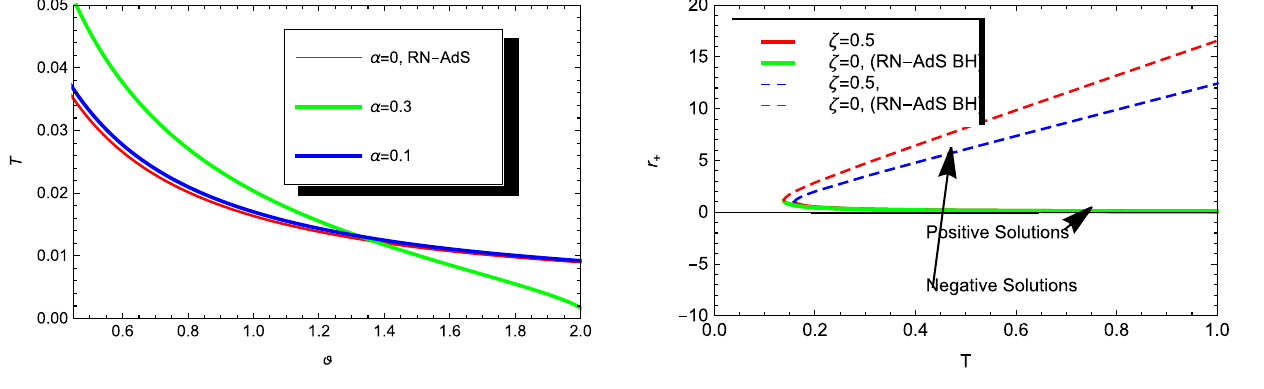
Fig. 10 Plot of the event horizon radius r + in terms of the temperature T